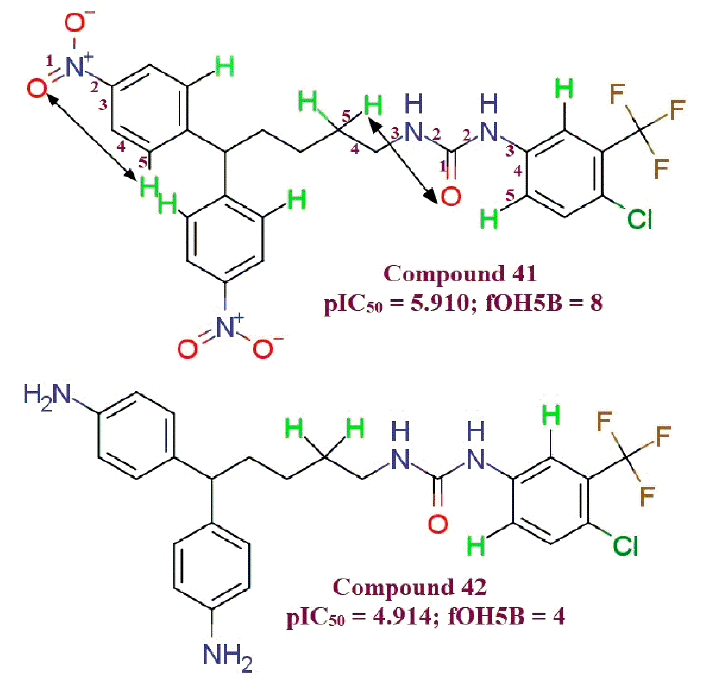
Figure 5. Illustration for molecular descriptor fOH5B . (Distinguished hydrogens are shown in green